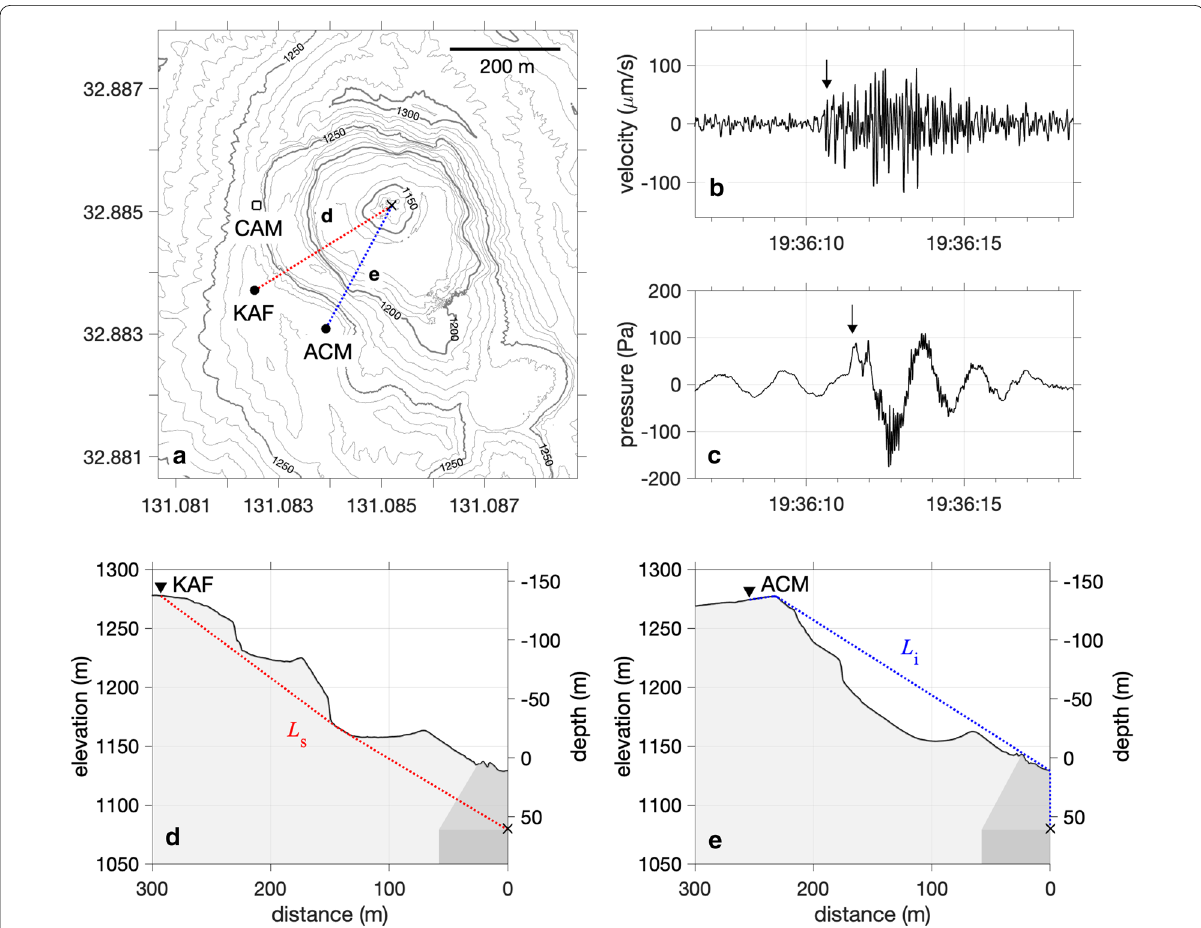
Fig. 1 Station locations and observed signals. a Topographic map around the active crater of Aso volcano. The seismic station (KAF) and infrasound station (ACM) are located on the crater rim ∼ 300 m from the vent (black cross). During the eruptive period, a surveillance camera was also installed on the rim (white square) and captured an image every 20 s. b Seismic and c infrasound signals were sampled at a rate of 100 Hz. When a Strombolian explosion occurred, the seismic signal arrived prior to the infrasound signal. Two arrows show the arrivals of the seismic signal and high-frequency infrasound component ( ∼ 15 Hz). The background of the infrasound signals is composed of a low-frequency component ( ∼ 0.5-Hz) derived from acoustic resonance inside the vent (Yokoo et al. 2019). d, e Cross sections between the vent and stations. L s and L i are the propagation paths of the seismic and infrasound signals from the source of explosion toward the stations (Eqs. (2),